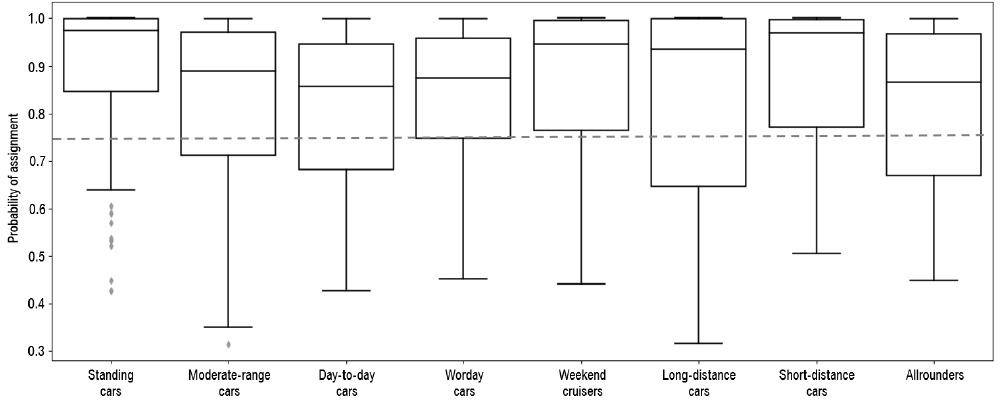
Figure 1. Probability of assignment among car usage